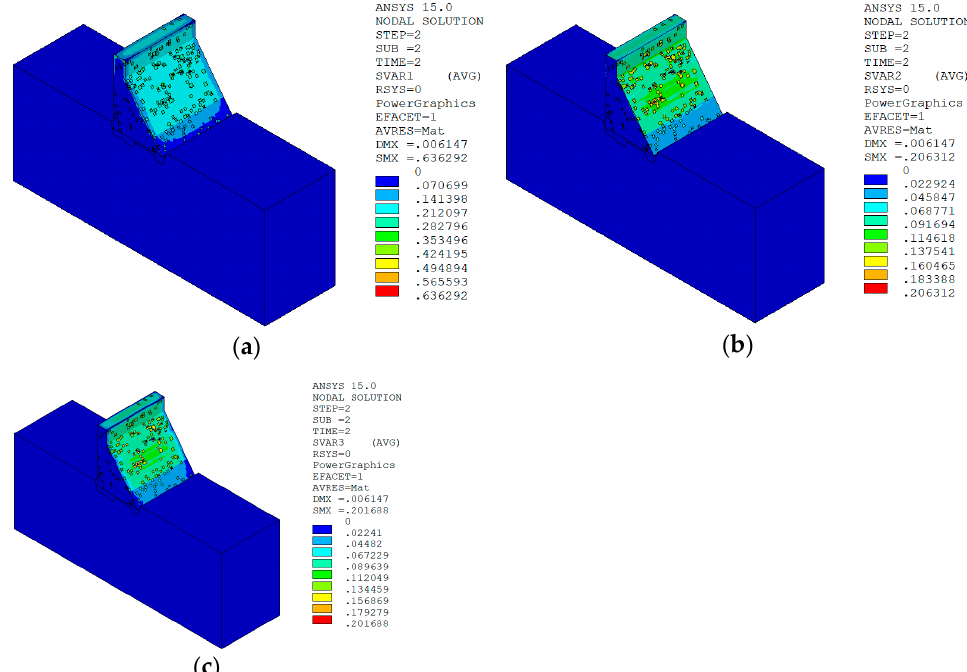
Figure 18. The temperature damage distribution of the dam body in the three principal strain directions is calculated by the macro-meso model under the temperature rise condition, ( a ) The temperature damage distribution in the first principal strain direction, ( b ) The temperature damage distribution in the second principal strain direction, ( c ) The temperature damage distribution in the third principal strain direction.